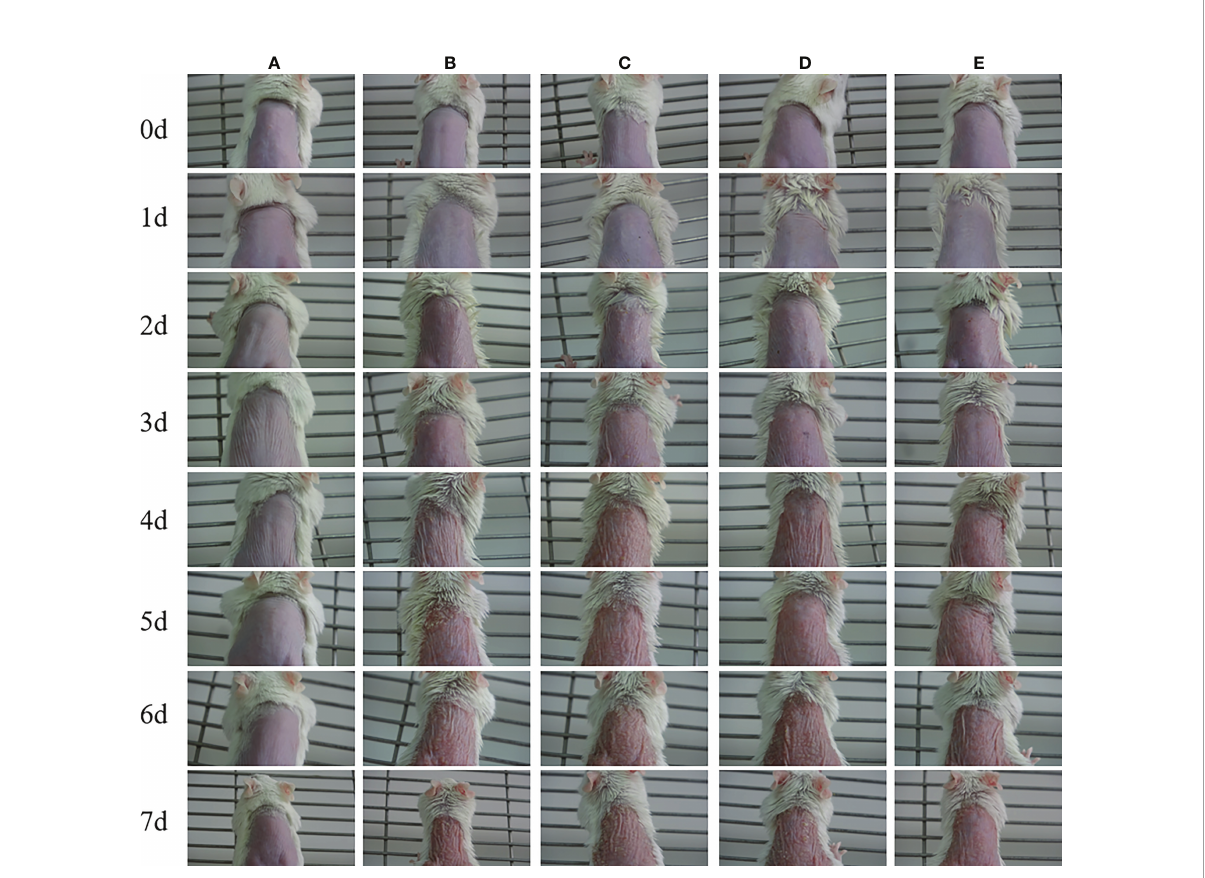
FIGURE 2 Representative images of psoriasis-like rash in each experimental group from 0 to 7 days after modeling. (A) Control-A; (B) Model-B; (C) hUC- MSMCs-C; (D) Indirubin-D; (E)